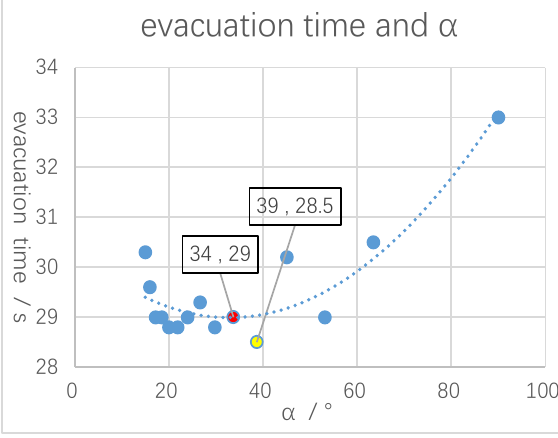
Table 3. Change export width as length changed